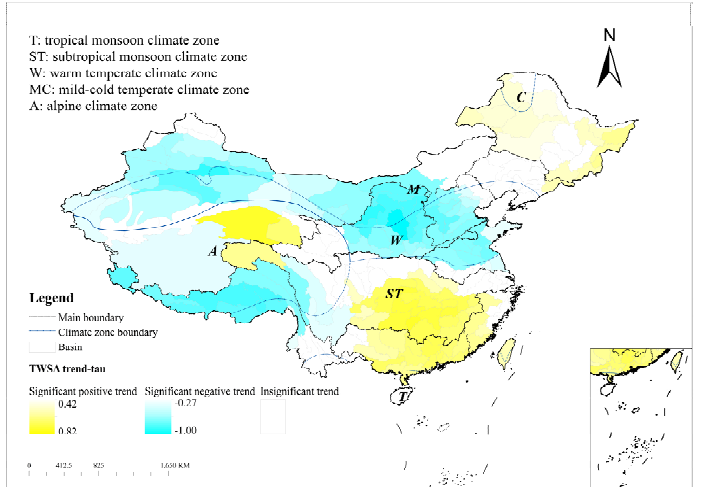
Figure 5. TWSAs trends from 2004 to 2014 in 214 watersheds in China ( p < 0.05).